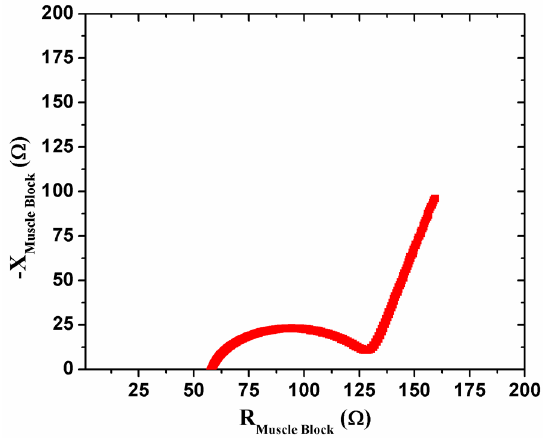
Figure-20: Nyquist plots tissue samples muscle tissue